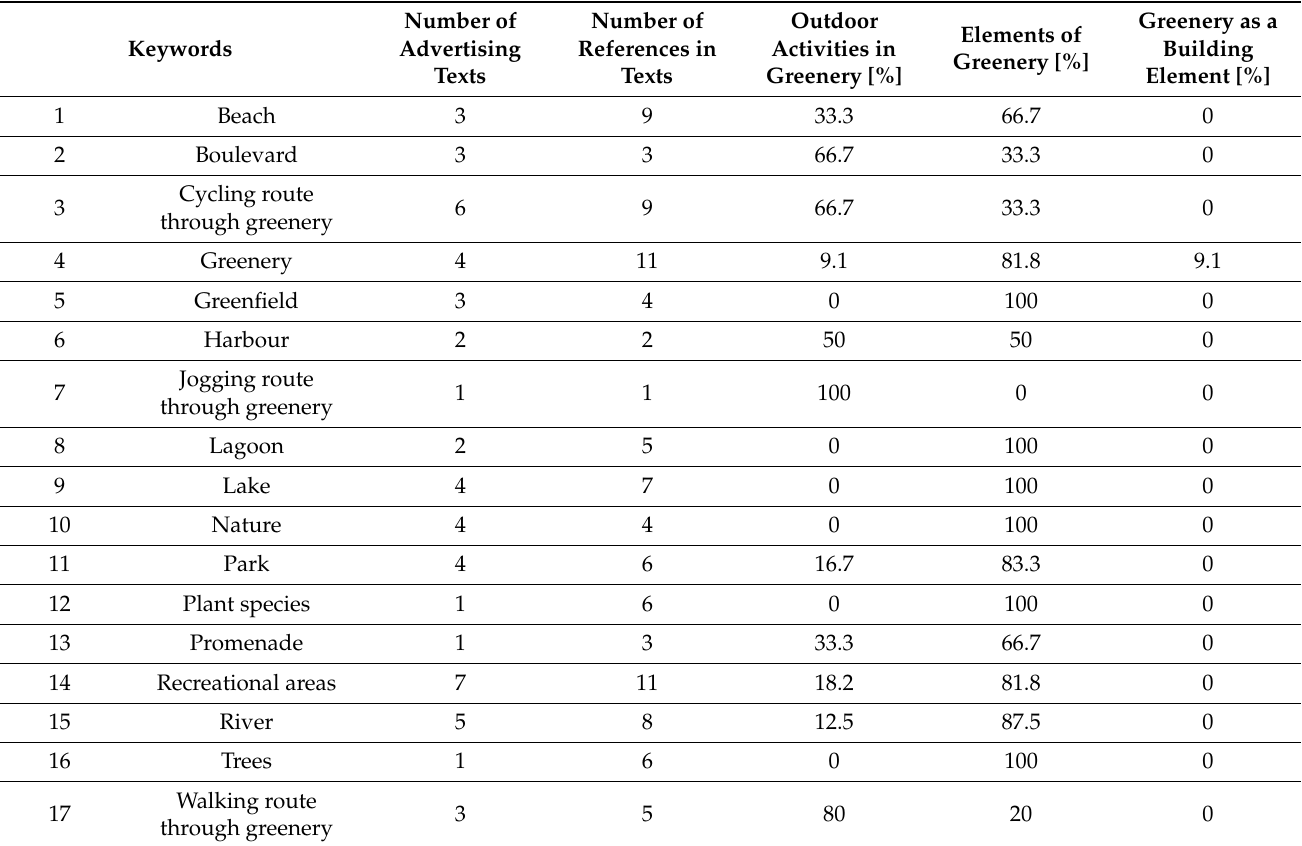
Table 5. The frequency of keyword coding in advertising texts, the total number of references, the percentage of keywords used in each first stage of the coding